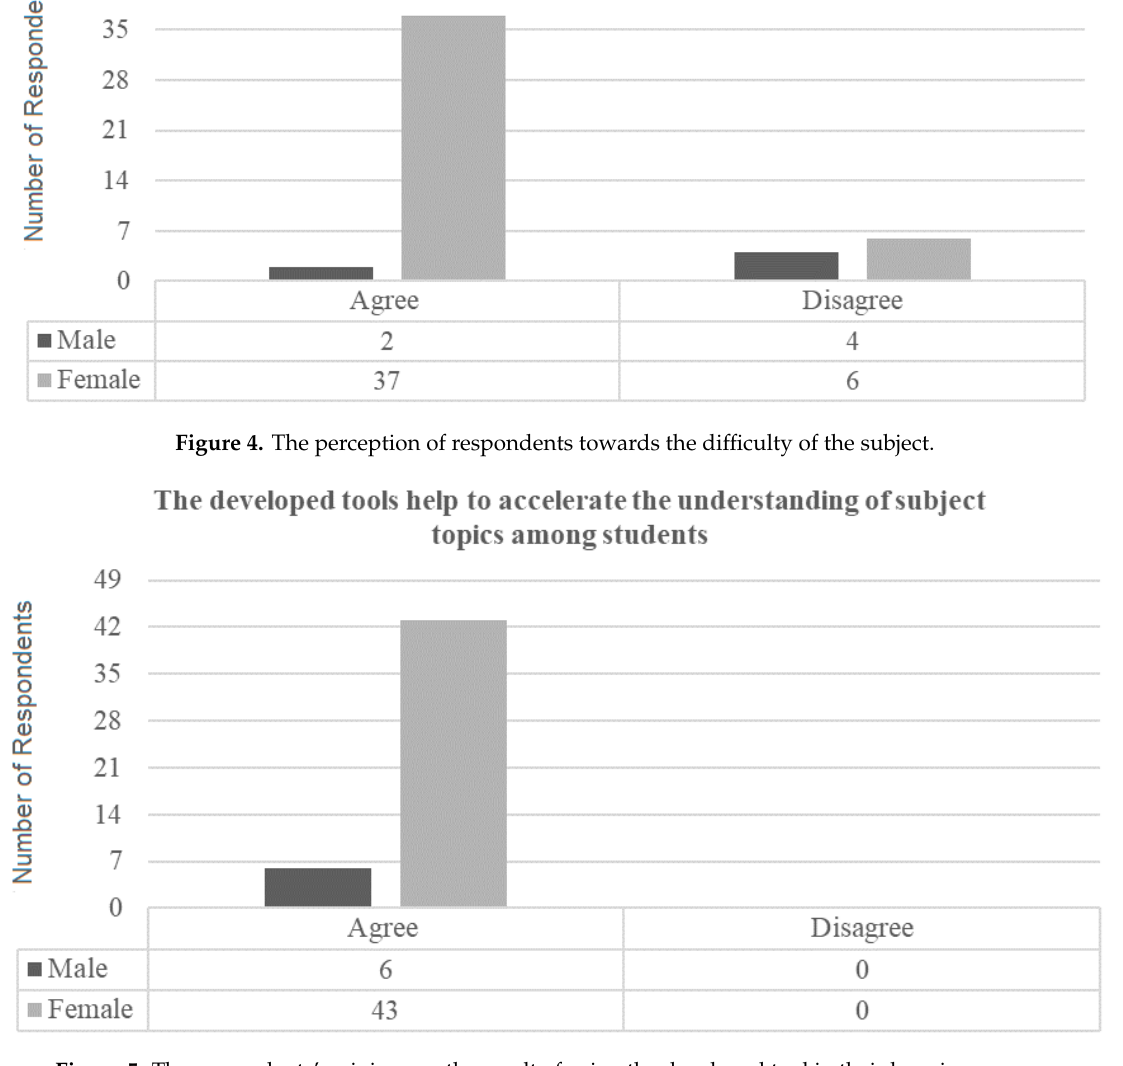
Figure 5. The respondents’ opinions on the result of using the developed tool in their learning process.